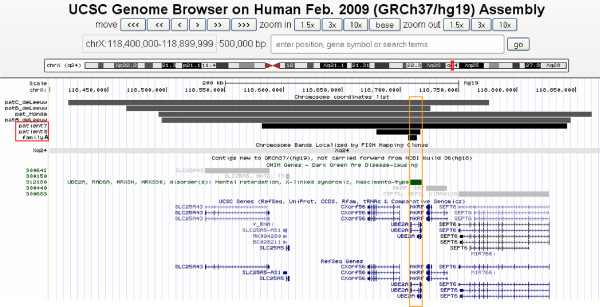
Comparison of the three Xq24 deletions encompassing UBE2A detected in this study (black bars) and the four deletions previously published in the literature (grey bars [6],[7]. The smallest deletion (family A) is just 7.1 kb in size and only affects exons 1–3 of UBE2A.